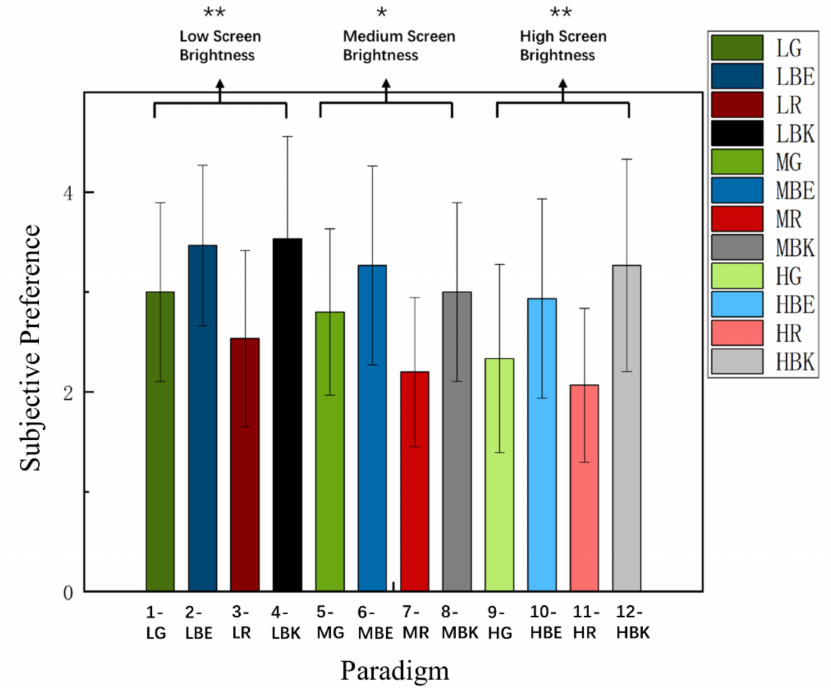
Figure 7. Comparison of the mean values and SD of SP for 12 paradigms over 15 subjects. Statistics were assessed by one-way repeated-measures ANOVA. ** p < 0.01; * p < 0.05. The same as before, there was a significant difference in the medium brightness group [F (2.683, 37.561) = 4.466, p = 0.011 *], to be more specific, there were significant dif- ferences (Bonferroni Post-Hoc Analysis, p = 0.004 **) between paradigm 6 (SP = 3.3) and paradigm 8 (SP = 2.2), which indicated that the subjects preferred paradigm 6 (MBE) to paradigm 8 (MR) in the medium brightness